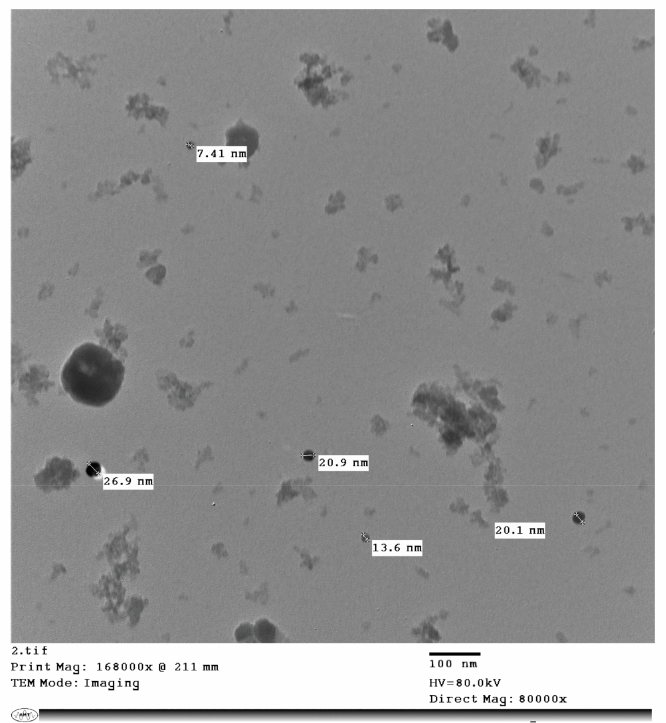
Figure 1. Transmission electron microscopy (TEM) of nano calcium nitrate particles using 80,000 ×